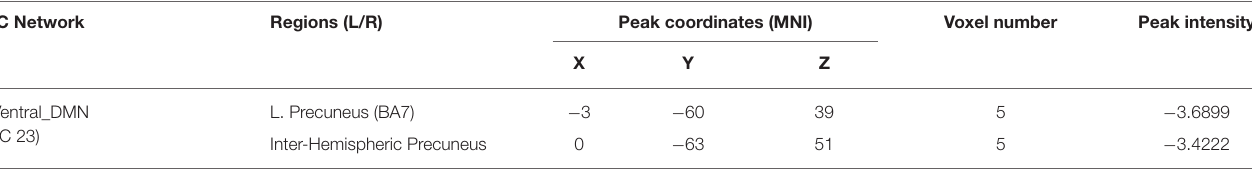
TABLE 2 | Brain regions showing significant within-network connectivity differences between ASD + ADHD and ASD groups. IC Network Regions (L/R) Peak coordinates (MNI) Voxel number Peak intensity X Y Z Ventral_DMN L. Precuneus (BA7) − 3 − 60 39 5 − 3.6899 (IC 23) Inter-Hemispheric Precuneus 0 − 63 51 5 −